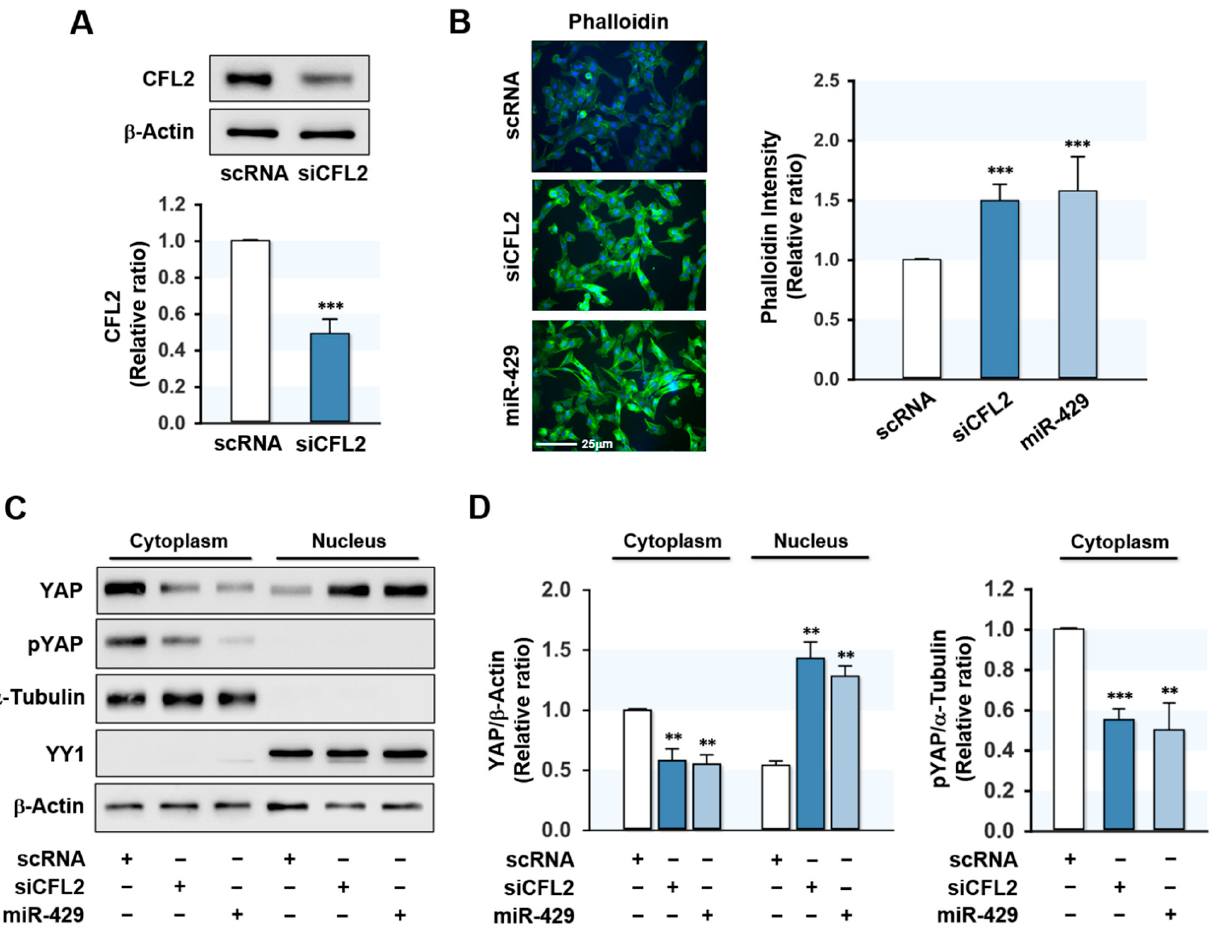
Figure 3. MiR-429-3p mimic elevated F-actin and nuclear YAP level. C2C12 myoblasts were transfected with 200 nM of scRNA, siCFL2, or miR-429-3p mimic. ( A ) After 24 h transfection, CFL2 protein expressions were determined by immunoblotting. ( B ) Representative images of FITC-phalloidin (green) representing F-actin staining. Scale bar: 25 µ m. Phalloidin intensity was analyzed by the ImageJ program. ( C , D ) Cytoplasmic and nuclear fractions of myoblasts were separated after 24 h of transfection, and subcellular fractionation was confirmed using cytoplasmic ( α -Tubulin) or nuclear (YY1) markers. The distribution of YAP and phospho-YAP (pYAP) was determined by immunoblotting and densitometry. Immunoblot results are shown as relative ratios vs. scRNA controls. All results are presented as means ± SEM ( n > 3), and levels of significance as ** p < 0.01; *** p < 0.001 vs. scRNA.